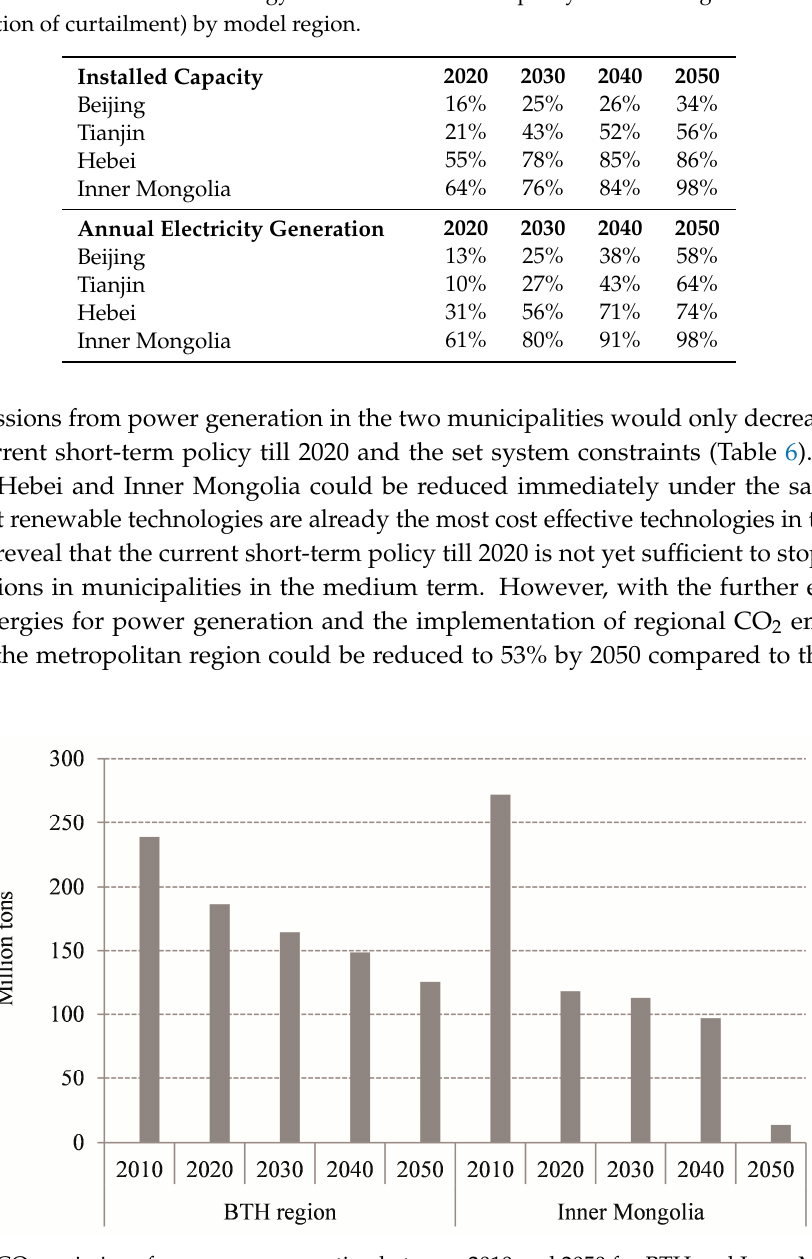
Figure 6. Mean marginal electricity costs over the optimization period by model region. 3.2. Total Installed Capacity Figure 7 shows the total installed capacities for power generation, electricity storage and grid transmission as a result of exogenously assumed existing installations and additionally required capacities as endogenous result of the system optimization. The total installed fossil-fired power plant capacity in the BTH region decreases after 2040 but only slightly and in line with the requirement of the total CO 2 emission cap. A switch from coal to gas does not take place in power generation in BTH due to the neglect of CO 2 emission costs and the cost advantages of extensive emission reduction in the Inner Mongolia supply region (see Figure 6). The share of PV in total installed capacity increases from 16% in 2020 to 73% by 2050 in BTH. Limited by the regionally available onshore wind potentials (36 GW and 31 GW if all sites below 4 m/s and 5 m/s wind speed,